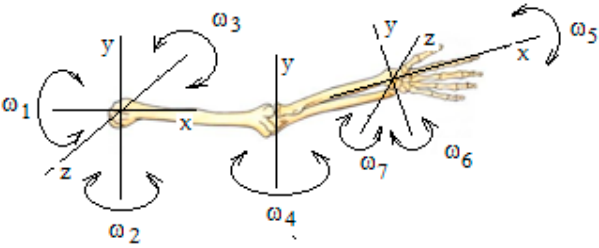
Figure 1. Anatomically and cinematically the human arm.